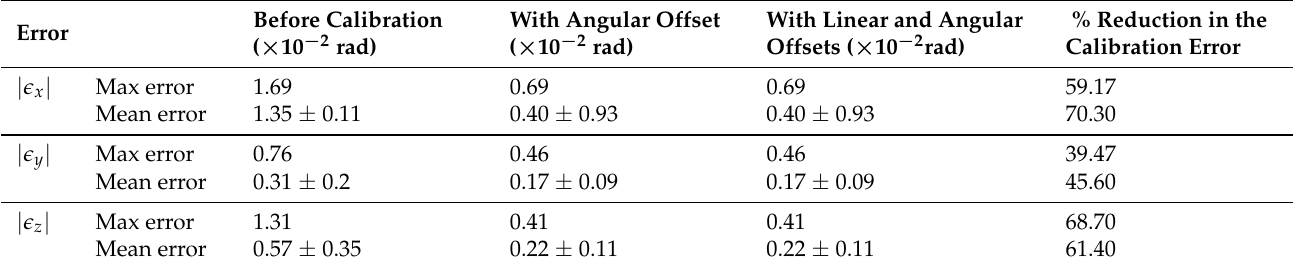
Table 7. Resultant orientation error before and after calibration.